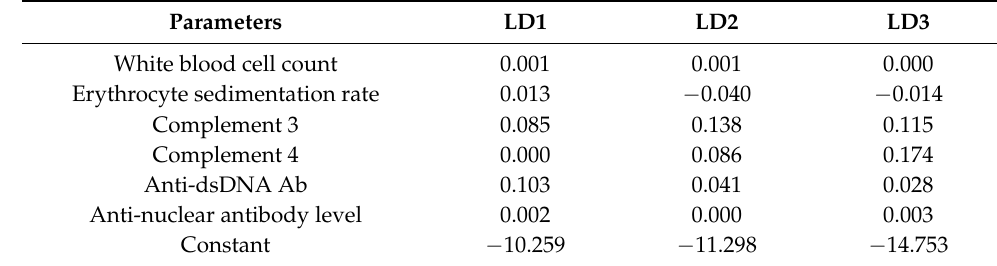
Table 2. Fisher’s linear discriminant functions for